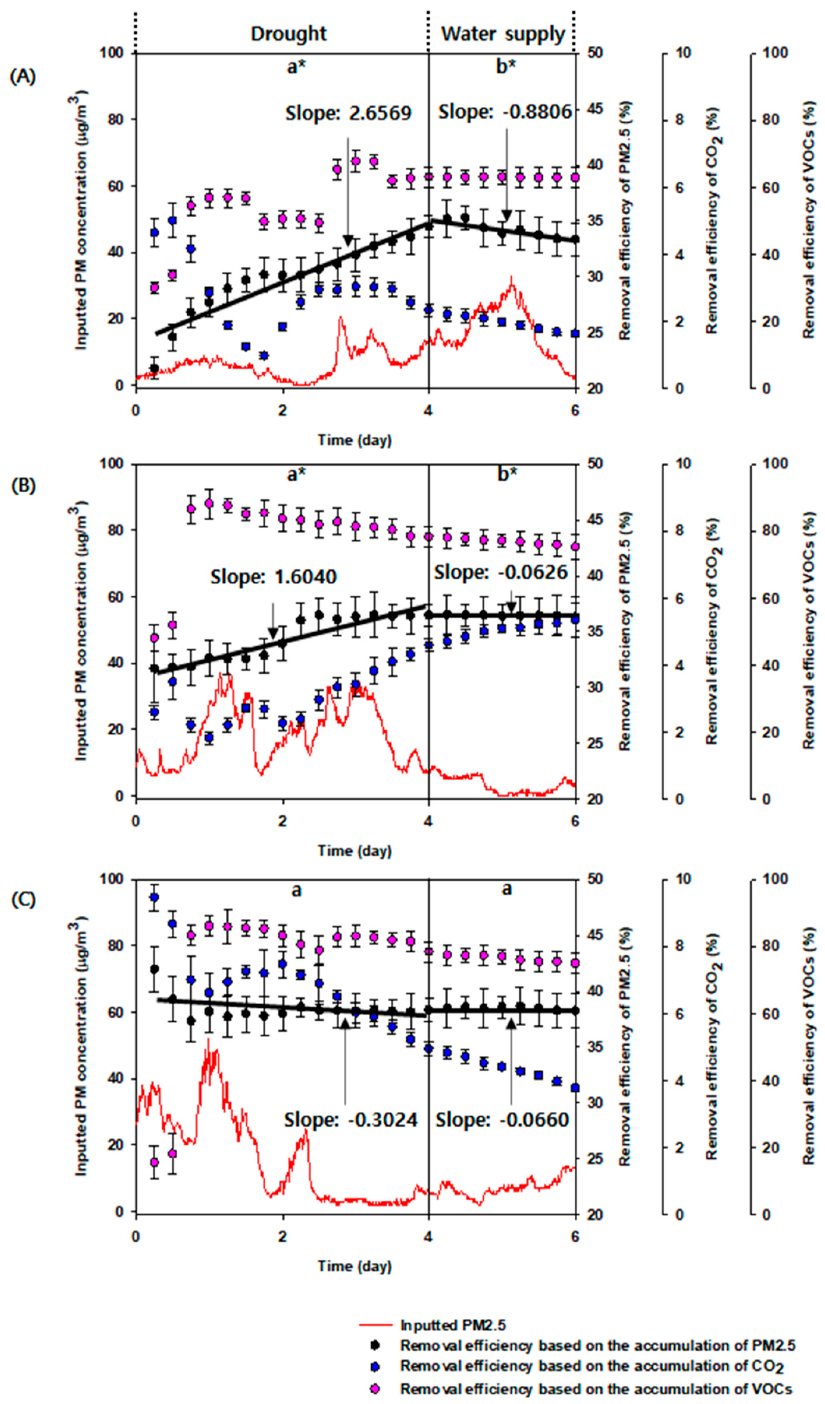
Figure 2. Removal efficiency of PM2.5, CO 2 , and VOCs by the plant-based biofilter system containing Ardisia japonica under ( A ) CL (continuous light), ( B ) LD cycle (light/dark cycle; 14 h/10 h), and ( C ) CD (continuous dark) with drought and with water supply in series. The error bars represent standard deviation. * is significance level of p < 0.05.